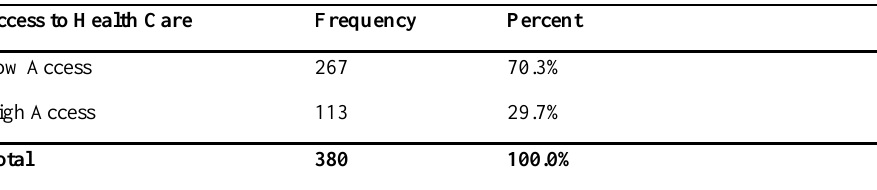
Table 4: Respondents distribution on access to health